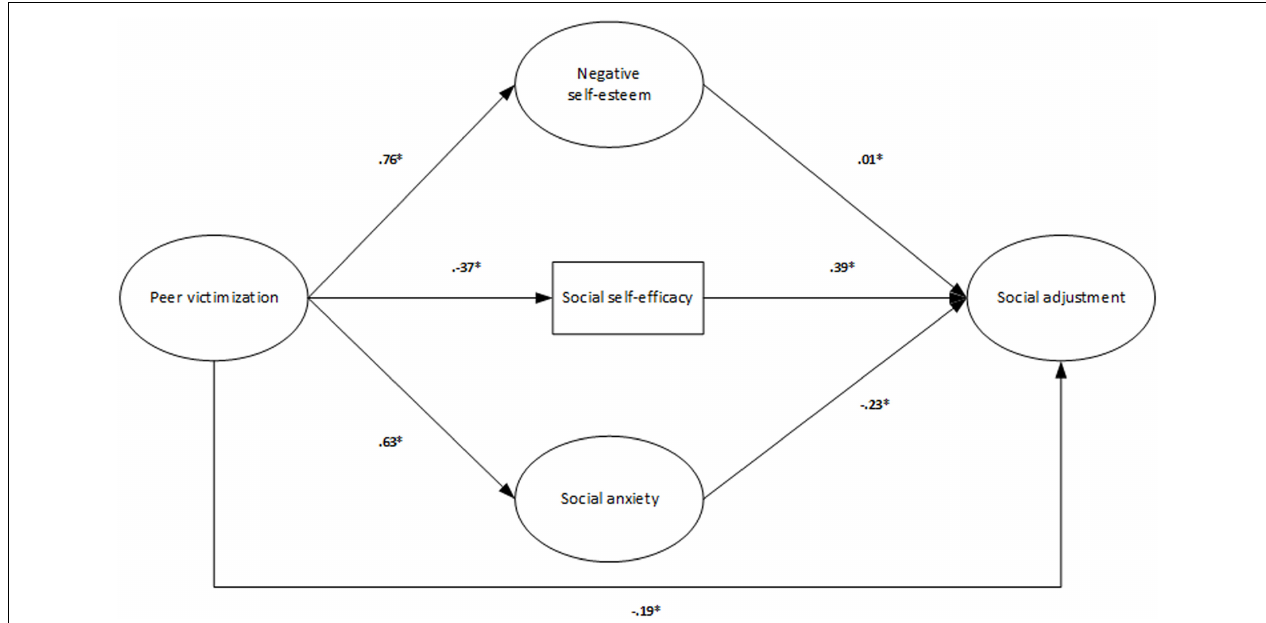
FIGURE 1 | Fourth model: direct and indirect relationships between victimization and social adjustment and direct relationship between psychological and social